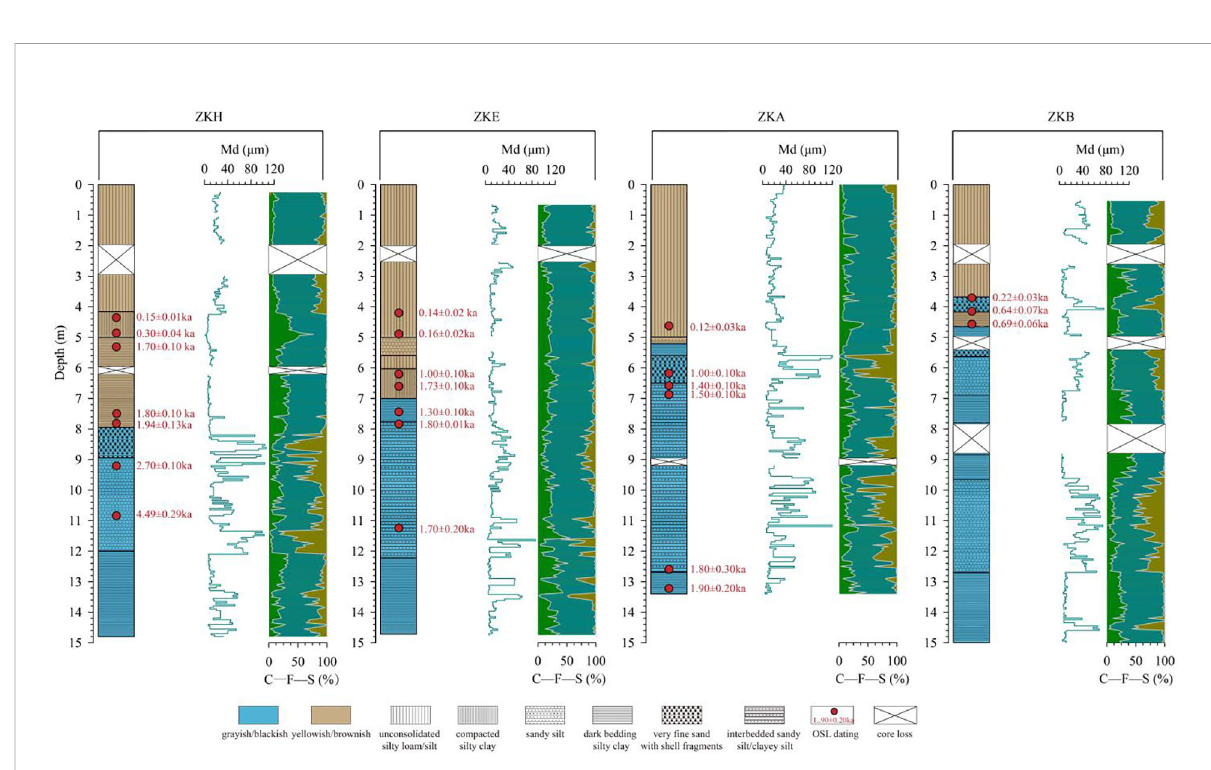
FIGURE 3 Pro fi les of lithology and selected grain size parameters for the four drilling cores. The OSL ages are also shown. Mz: mean grain size; C ! F ! S: the contents of clay, silt and sand, respectively.